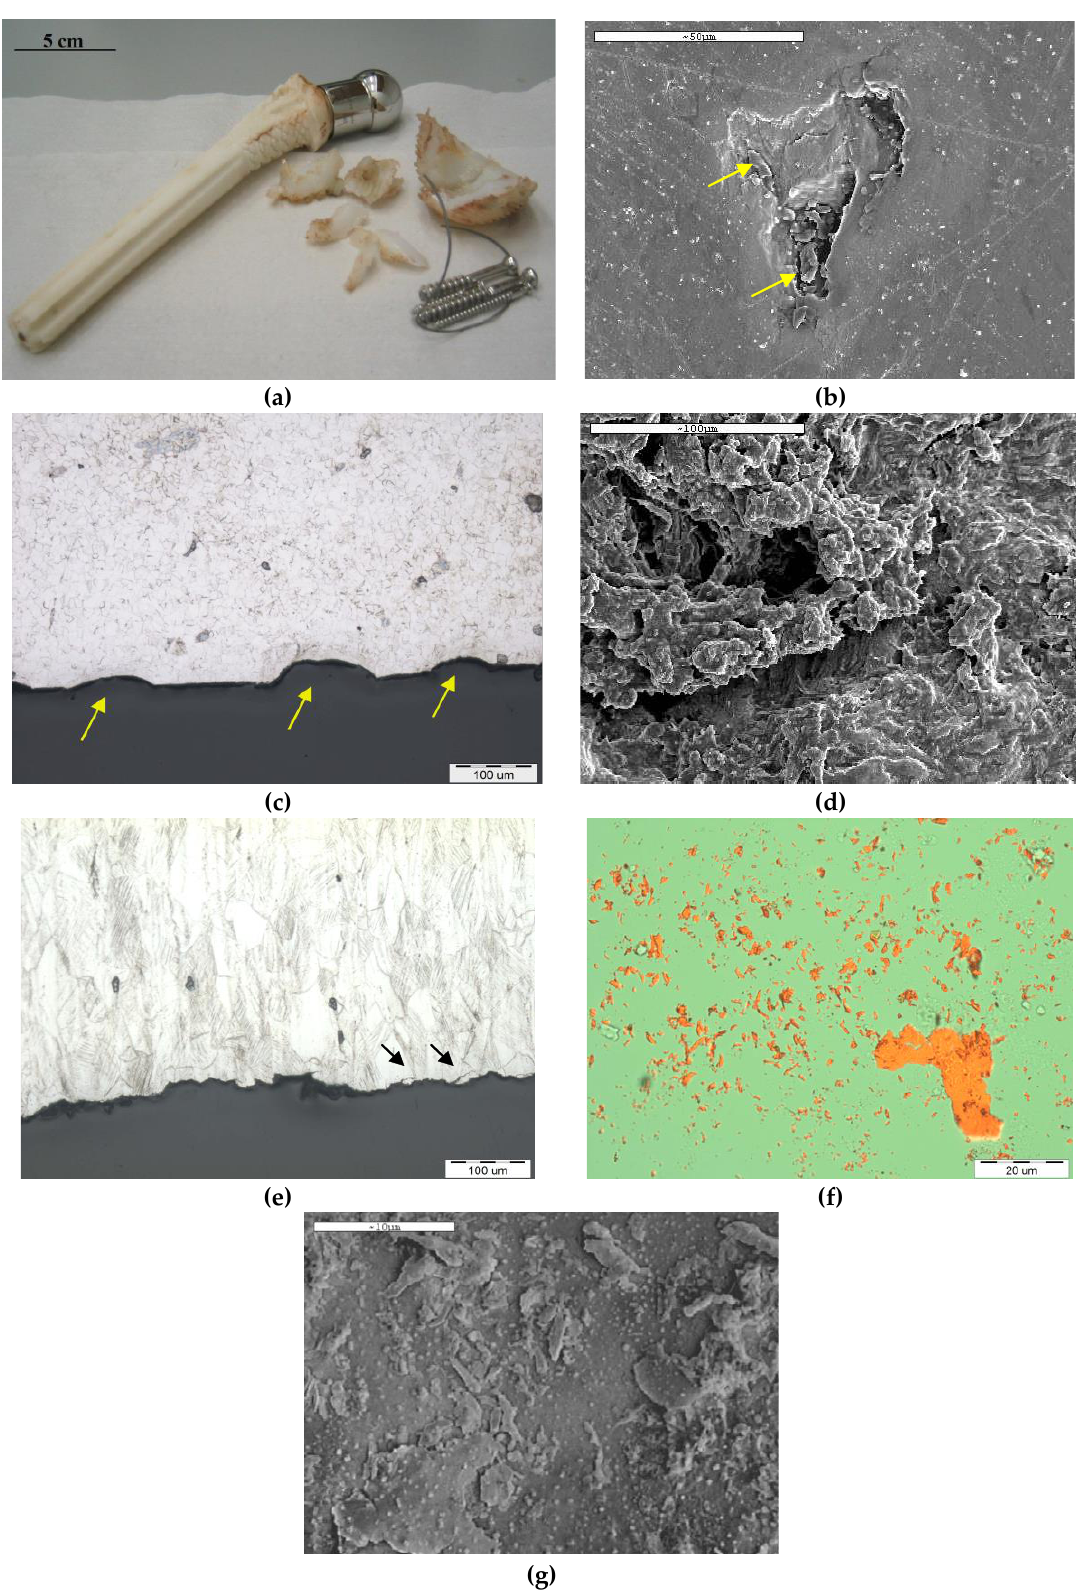
Figure 4. The use of Bio-Ferrography in the study of biodegradation of artificial hip joint. ( a ) A retrieved cementless isoelastic hip joint. ( b , c ) SEM and optical microscope images of pits on the neck surface. ( d,e ) Transgranular SCC of a stainless steel screw. ( f,g ) Isolated 316L stainless steel particles as seen under an optical microscope with bichromatic illumination ( f ) and by SEM ( f ).